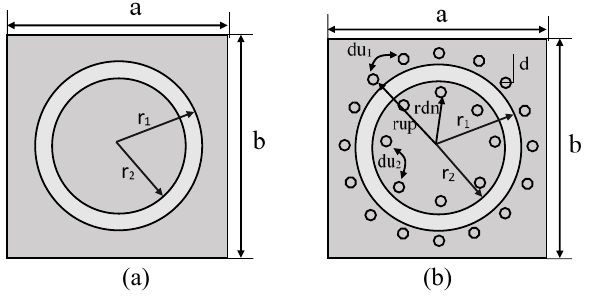
Figure 9. Unit cell configuration of FSS: (a) Ring aperture FSS. (b). SIW cavity ring aperture FSS (design parameters are referred from [28]).